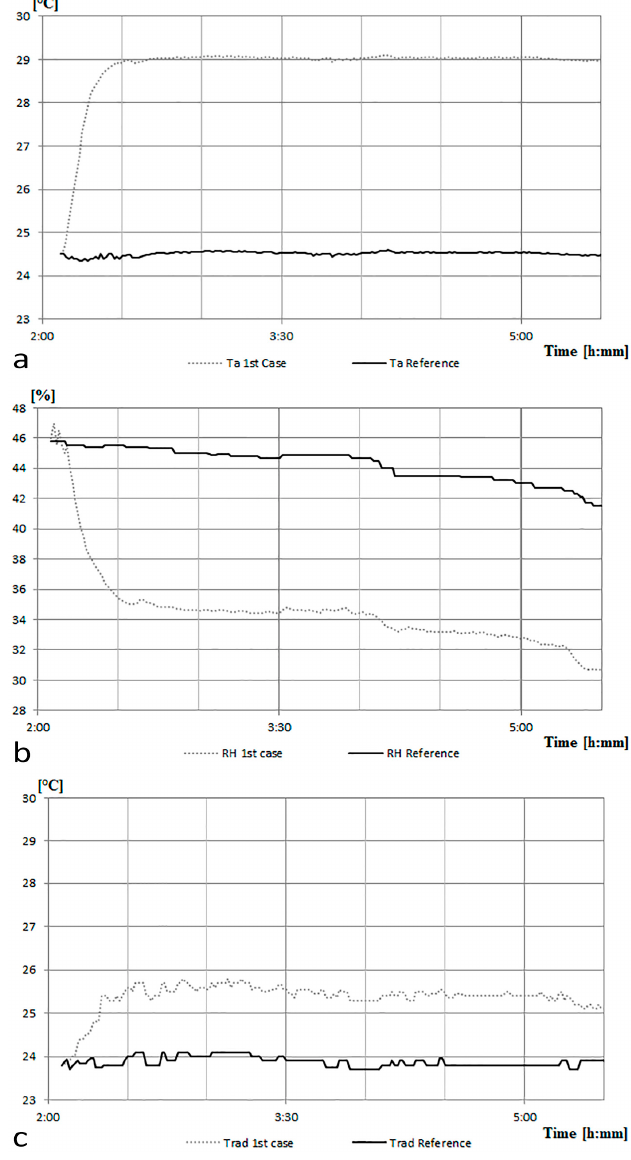
Figure 5. The first case vs the reference sensors: ( a ) air temperature (Ta) data; ( b ) relative humidity (RH) data; and ( c ) radiant temperature (Trad) data.